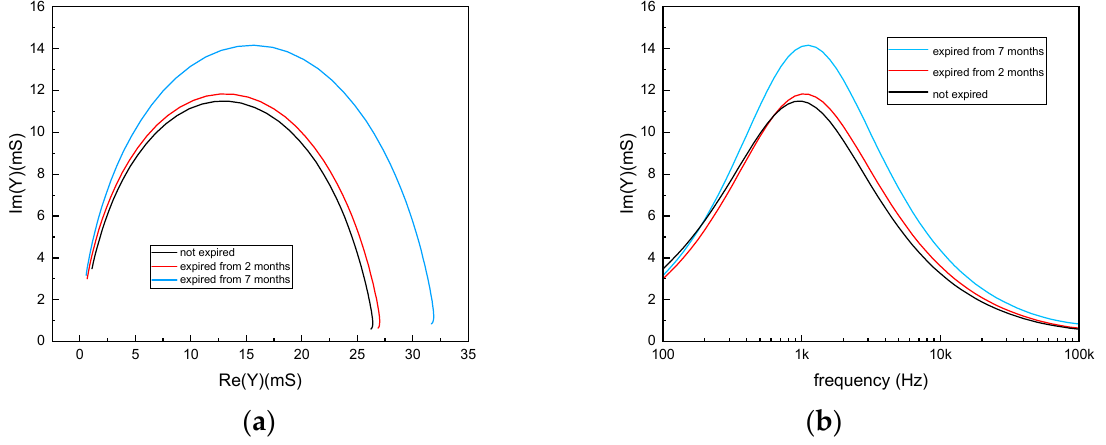
Figure 13. Comparison among not expired milk, milk expired from 2 months and milk expired from 7 months. The samples belonged to the same type and brand of milk. In ( a ) the Nyquist plots are shown, in ( b ) the Imaginary parts of the admittance, to highlight the modification of the electrical characteristics of expired milk even for frequencies lower than the relaxation frequency of the electrode polarization.